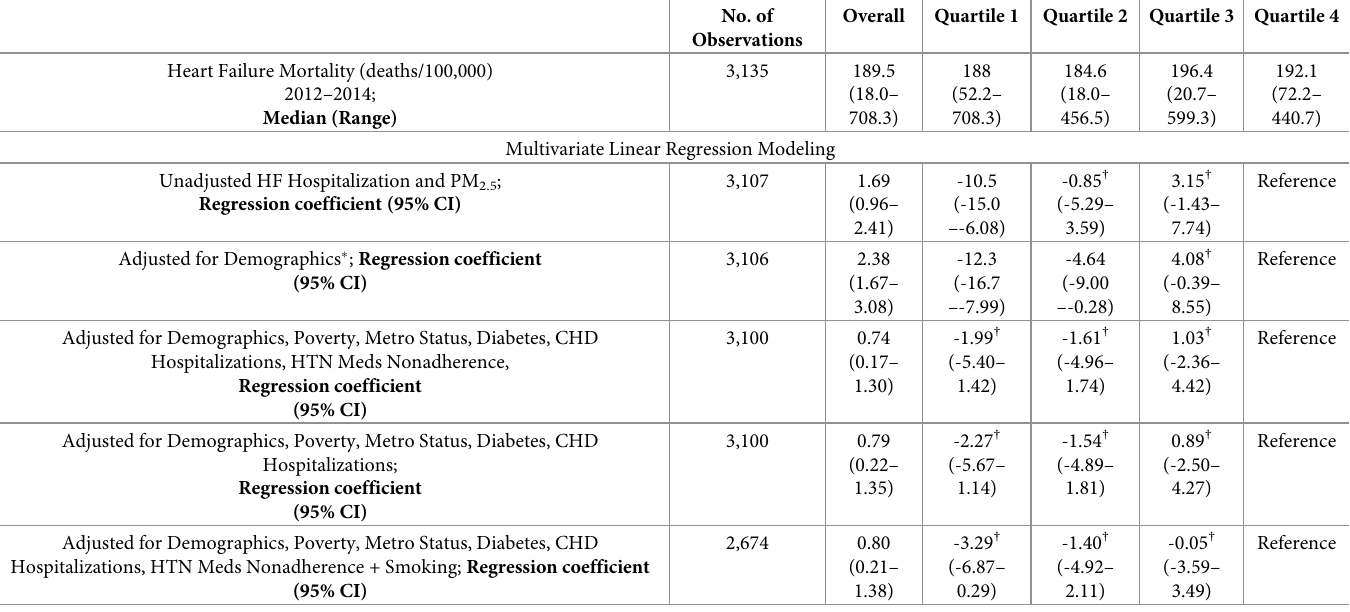
Table 4. HF Mortality analytic-weighted multivariate linear regression modeling.